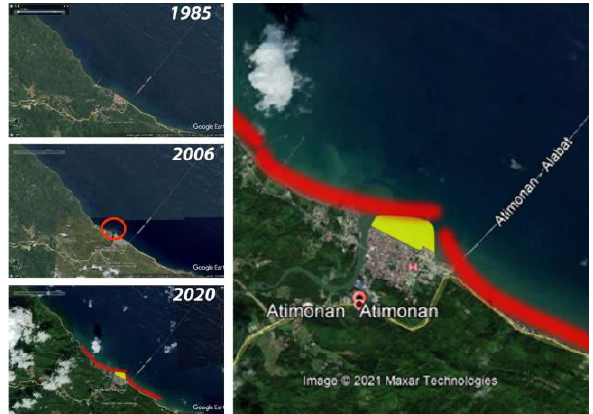
Figure 5 . Historical satellite images of study area taken from Google Earth Pro. The proposed crenulate bay is highlighted in yellow, while the red line illustrates the shape where the crenulate bay was derived.